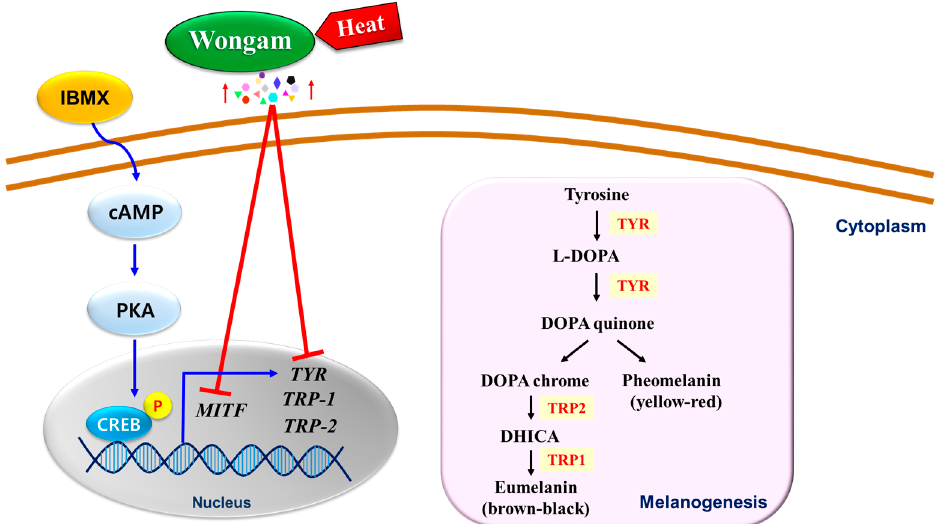
Figure 8. Schematic model of anti-melanogenic effects of heated Wongam in B16F10 melanoma cells. The red line and blue arrows indicate inhibition and stimulation, respectively. Heat treatment can increase the content of phenolic compounds such as ISL, linked to anti-melanogenic activities via regulating melanogenesis-related genes and proteins, in licorice.